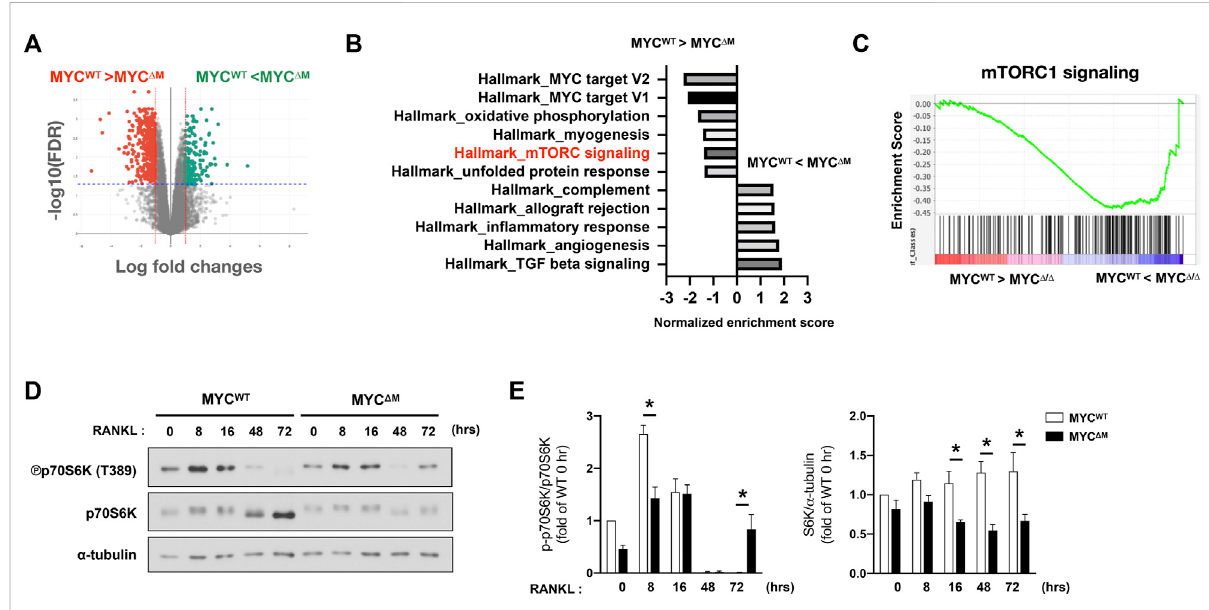
FIGURE 1 MYC regulates mTORC1 activity in osteoclastogenesis. (A) Mouse BMDMs from control (MYC WT ) mice and MYC-de fi cient (MYC Δ M ) mice were stimulated with RANKL for 1 day. Volcano plot of differentially expressed genes (DEGs) in MYC-de fi cient cells relative to control cells after RANKL stimulation for 24 h from the RNAsequencing (RNA-seq) analysis ( > 1.5 fold). (B,C) Gene-set – enrichment analysis of DEGs with genes ranked on the basis of expression in MYC Δ M relative to that in MYC WT , showing the distribution of genes in the mTORC1 signaling gene set against the ranked list of the genes from the RNA-seq analysis. NES: normalized enrichment score, the primary statistic for examining gene set enrichment results. (D) Immunoblot of whole-cell lysates from control and MYC-de fi cient BMDMs after RANKL stimulation for the indicated time points with anti-phospho p70S6K, p70S6K, and α -tubulin antibodies. α -tubulin served as a loading control. Data are representative of four experiments. (E) Graph depicts the quanti fi cation of signal intensity of the phospho p70S6K and total p70S6K immunoblot using densitometry, normalized to WT control. Data are shown as mean ± SEM ( n = 4). * p < 0.05 by one-way ANOVA with a post hoc Tukey